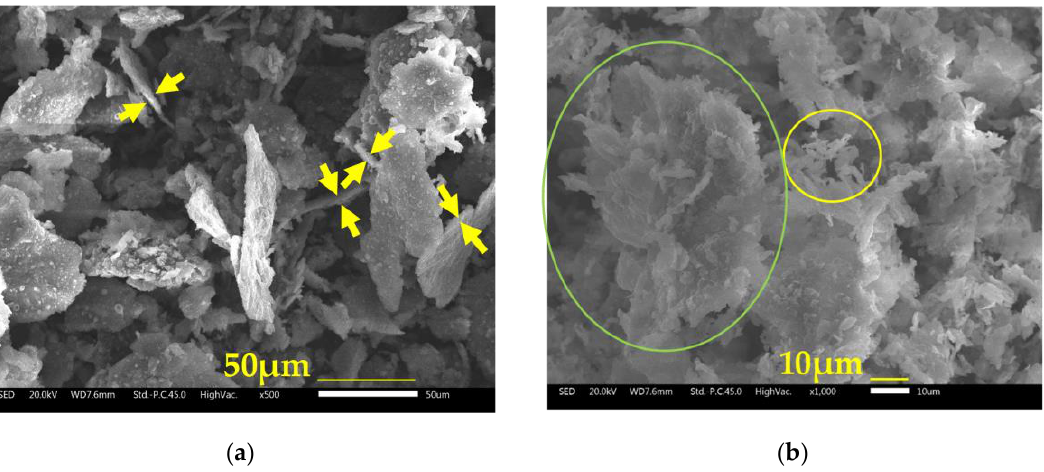
Figure 8. ( a ) SEM image of as cryogenically milled Mg-15wt.% VCl 3 . ( b ) SEM image of hydrided (at 350 °C and 26 bar) Mg-15wt.% VCl 3 material. Green oval: flake. Yellow oval: dendritic